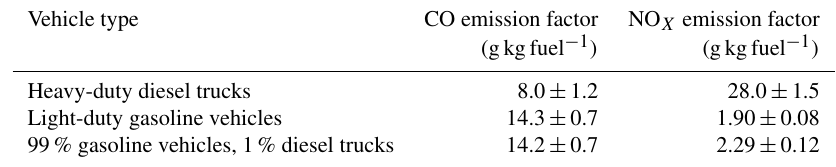
Table 2. Reported emission factors of diesel and gasoline vehicles (Dallmann et al., 2011, 2012, 2013). Emissions from medium-duty and heavy-duty diesel trucks, which account for <1% of all vehicles, were removed to give the value for light-duty gasoline vehicles.